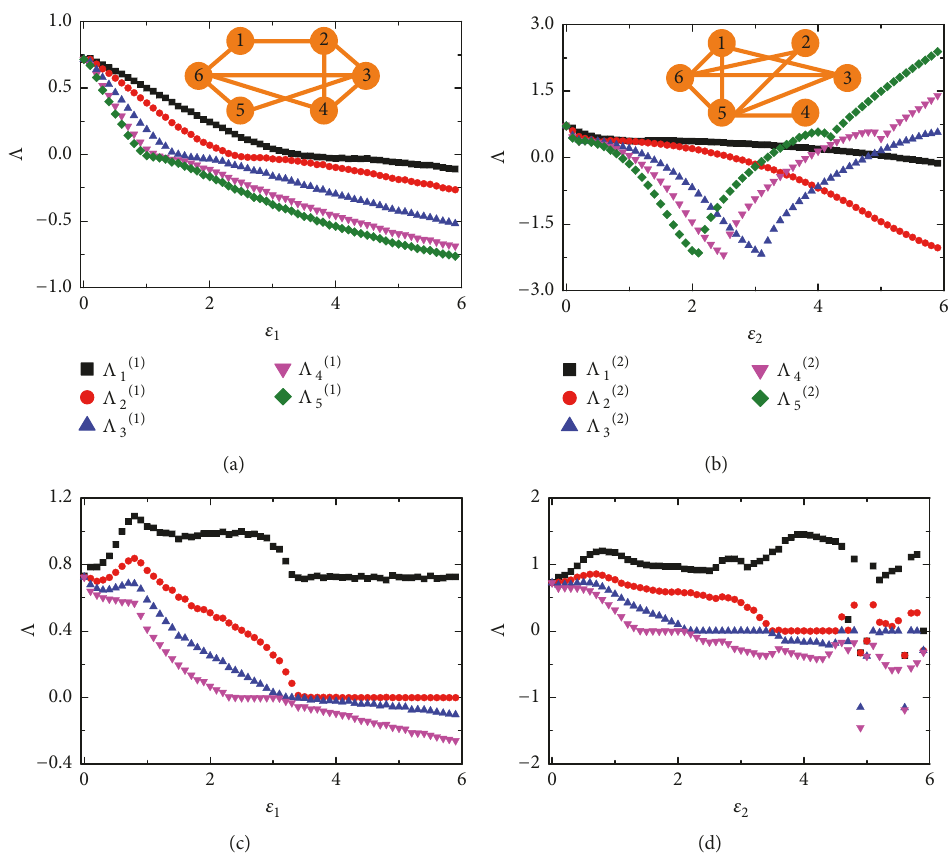
Figure 1: The transversal Lyapunov exponents for different transversal network modes are plotted against the coupling strength in (a) for the layer 𝐿 (1) and in (b) for the layer 𝐿 (2) . The insets in these two plots show the network structures of 𝐿 (1) in (a) and of 𝐿 (2) in (b). The first four largest Lyapunov exponents are plotted against the coupling strength in (c) for the layer 𝐿 (1) and in (d) for the layer 𝐿 (2) . 𝑁 = 6